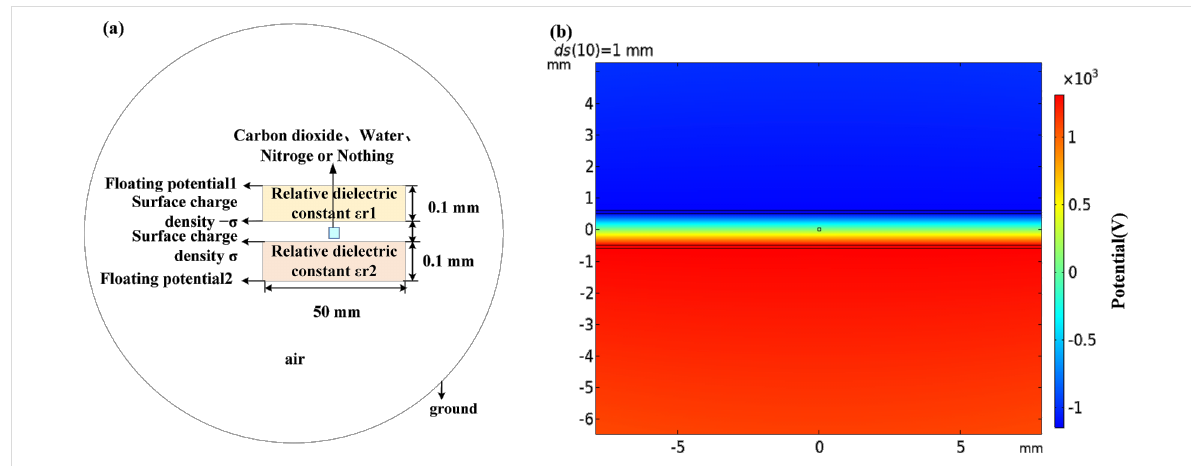
Figure 6: (a) TENG with a gas jet between two triboelectric materials. (b) TENG potential distribution diagram with gas